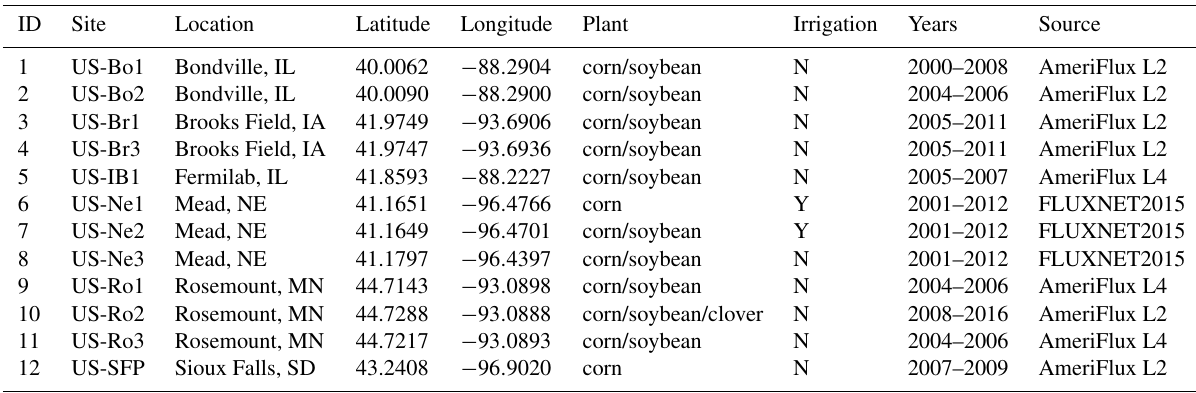
Figure 2. Study areas. Red dots indicate 12 flux-tower sites scattered in six areas across the US Corn Belt. The background map indicates the percent each state contributes to the total national corn and soybean plantation area (USDA, 2018). The background image is a © NASA Blue Marble image. Table 3. Information of 12 flux-tower sites used for